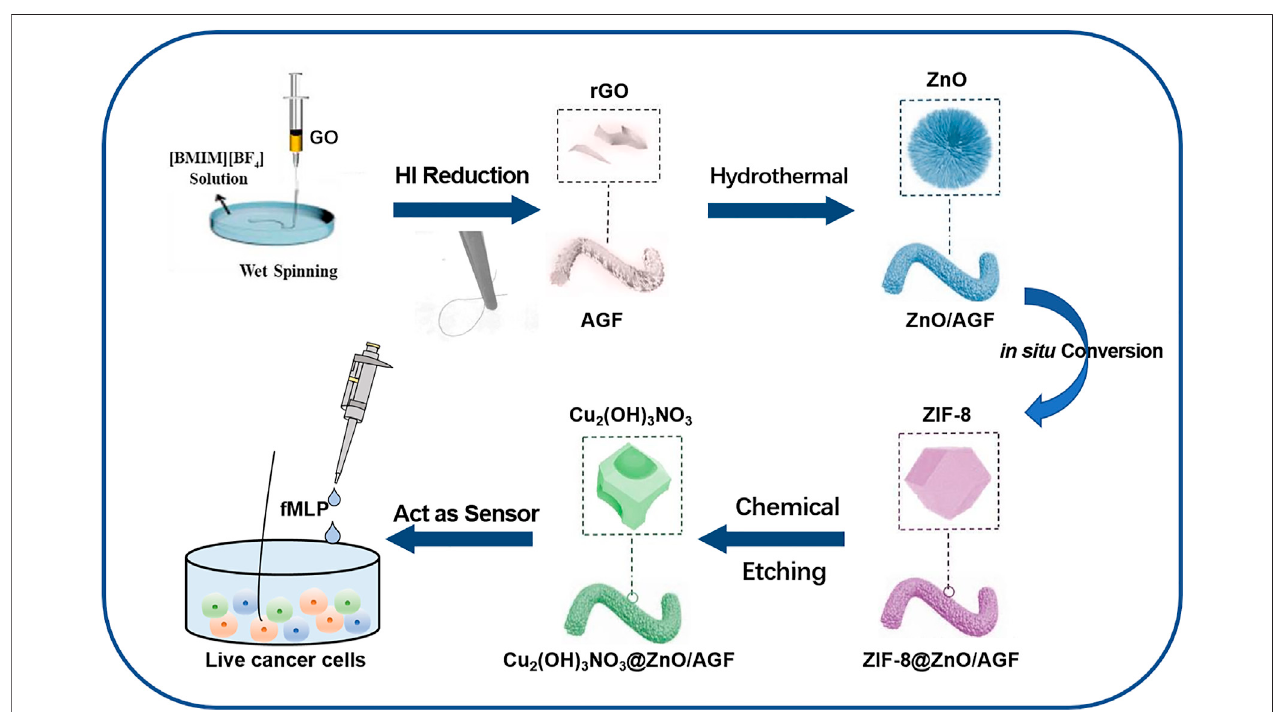
FIGURE 1 | Fabrication procedure of a rime-like Cu 2 (OH) 3 NO 3 @ZnO/AGF microelectrode for live cancer cell detection.